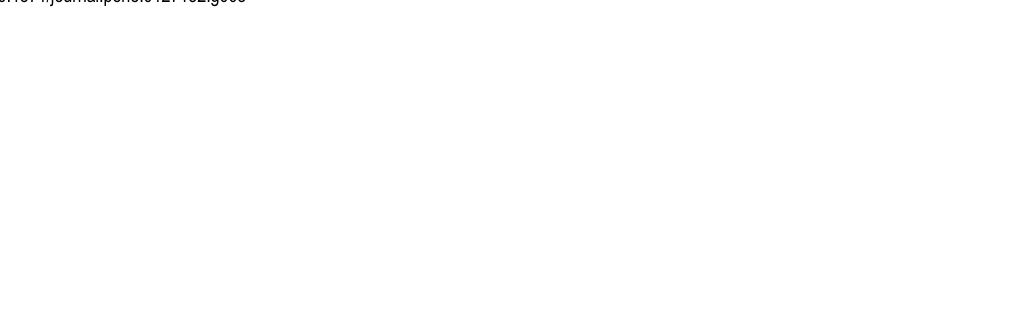
PLOS ONE | DOI:10.1371/journal.pone.0127152 June 1,